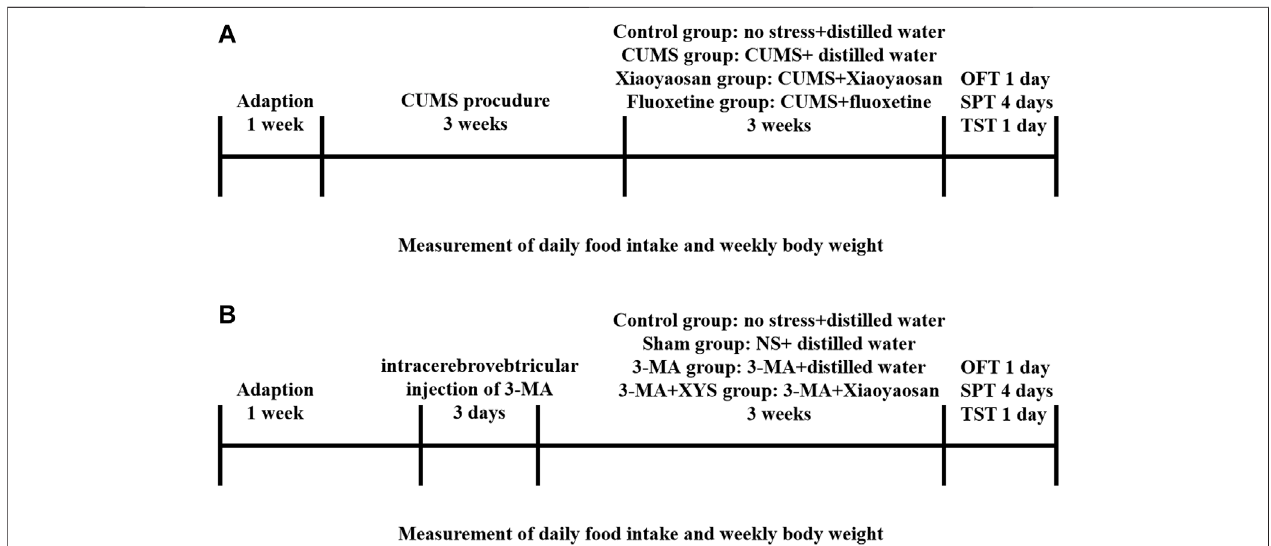
FIGURE 1 | Experimental schedule in this study. (A) After 1 week of habituation, except for those in the control group, the fi rst mice in the three other groups were subjected to chronic unpredictable mild stress (CUMS) stress for 3 weeks. The mice in each group received the corresponding treatment for 3 weeks after the stress ended. Daily food intake and weekly body weight were recorded from the fi rst day of stress until the end of treatment. The open fi eld test (OFT), sucrose preference test (SPT) and tail suspension test (TST) were performed. Then, the animals were sacri fi ced, and tissue was collected and cryopreserved. (B) After 1 week of habituation, except for those in the control group, the fi rst mice in the three other groups were injected with NS and 3-MA respectively. The mice in each group received thecorrespondingtreatmentfor3 weeksaftertheinjection.Dailyfoodintakeandweeklybodyweightwererecordedfromthe fi rstdayofwoundrecoveryuntiltheendof treatment. The open fi eld test (OFT), sucrose preference test (SPT) and tail suspension test (TST) were performed. Then, the animals were sacri fi ced, and tissue was collected and cryopreserved.